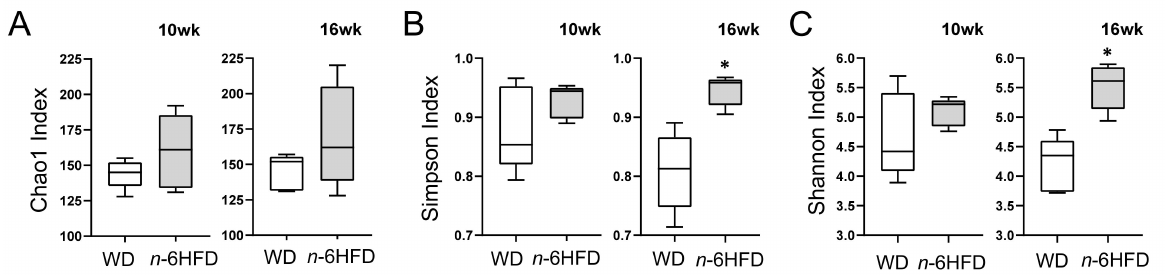
Figure 5. Alpha-diversity of cecal microbiota in C57BL/J6 male mice fed the WD or n -6HFD. Box and whisker plots depict alpha-diversity of cecal microbiome in 10-weeks- and 16-weeks-old C57BL/J6 male mice fed the WD or n -6HFD estimated using the ( A ) Chao1, ( B ) Simpson, and ( C ) Shannon Index. Differences between the WD and n -6HFD were analyzed using the Mann–Whitney U test. Medians with an asterisk (*) differ, p < 0.05 ( n = 5).